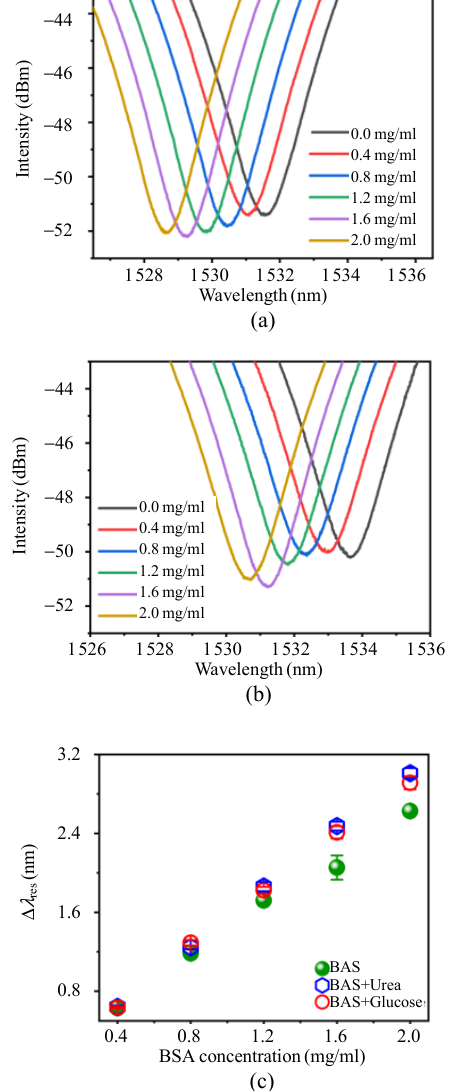
Fig. 5 Sensing results of the GMLPG in the presence of urea and glucose: (a) and (b) are the transmission spectra of the GMLPG with different BSA concentrations in the presence of λΔ of the GMLPG urea and glucose, respectively; (c) res against the BSA concentration in DI water, urea, and glucose, respectively.